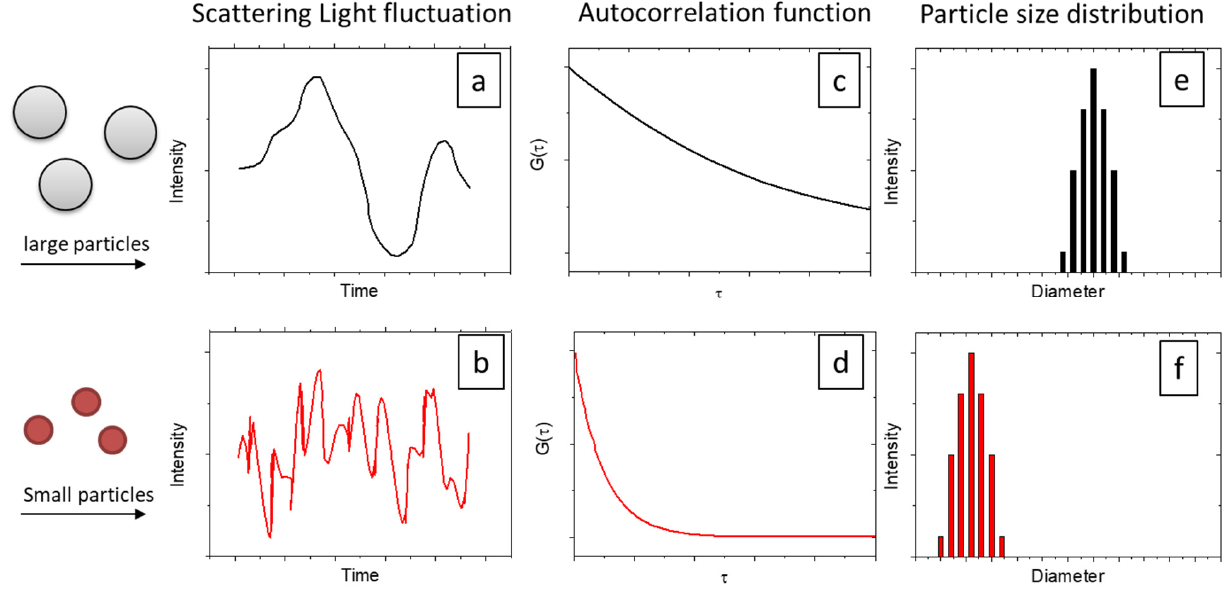
Figure 1. The effect of particles’ size on the fluctuations of the scattered light intensity ( a , b ), the corresponding autocorrelation function—ACF ( c , d ) and the particle size distribution ( e , f ). The form of the spectrum of light scattering may be changed not only because of the Brownian motion of scattering centers, but their number in the observation volume is of im- portance; in opaque colloids the multiple scattering events prohibit reliable